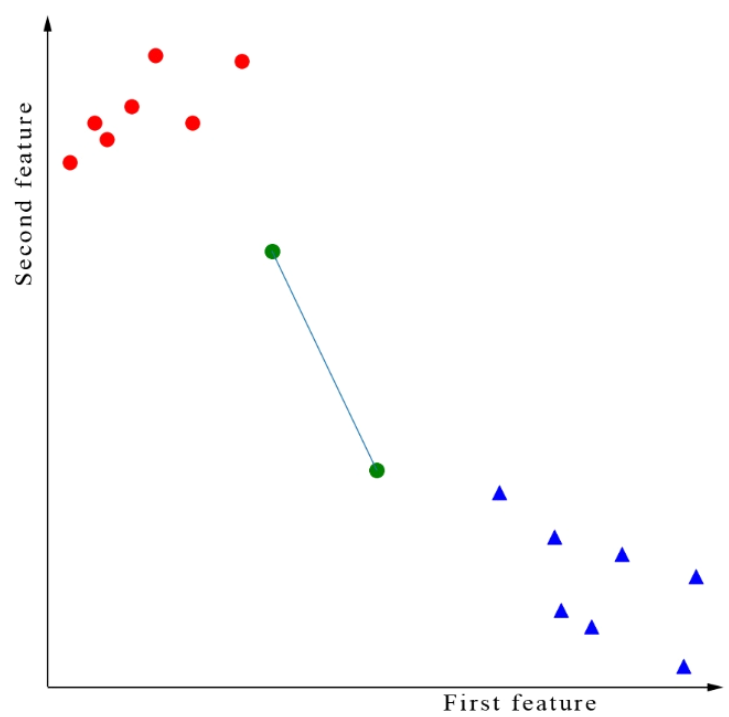
Figure 8. Update of shifting origin and shifting support direction vector using gradient descent optimization.